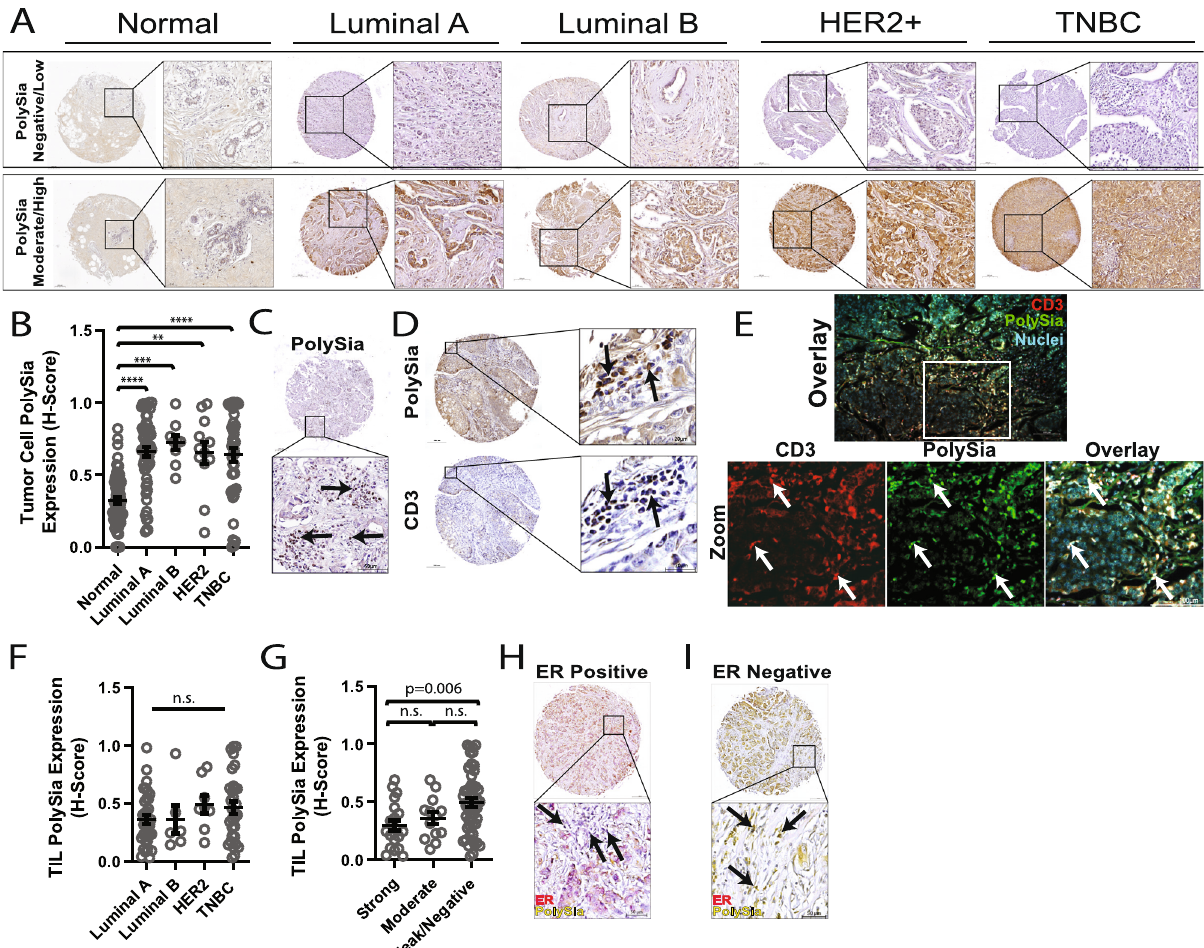
row) and high expression (bottom row). Cores are shown alongside higher magni fi cation insets from the same core. B Analysis of polysialic acid expression ( H -Score) in normal breast tissue and tumor cells categorized into molecular subtype. Luminal A ( n = 60), Luminal B ( n =